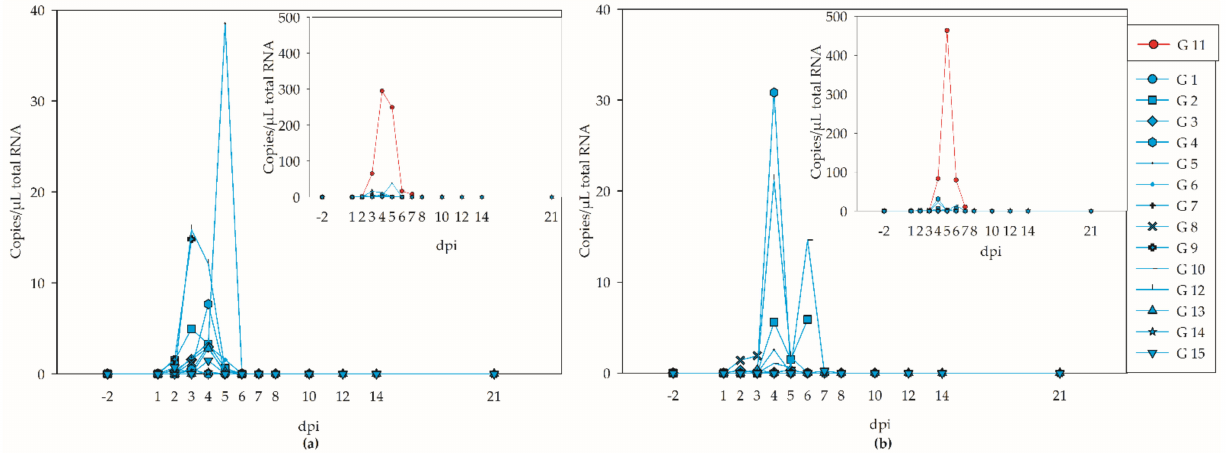
Figure 4. Viral shedding of the geese, without G 11 (left), and of all WNV-inoculated geese (top right), as estimated by RT-qPCR and using different y-scales. The negative results for the controls (G 16–G 18) are not shown. ( a ) Oropharyngeal shedding. ( b ) Cloacal shedding.